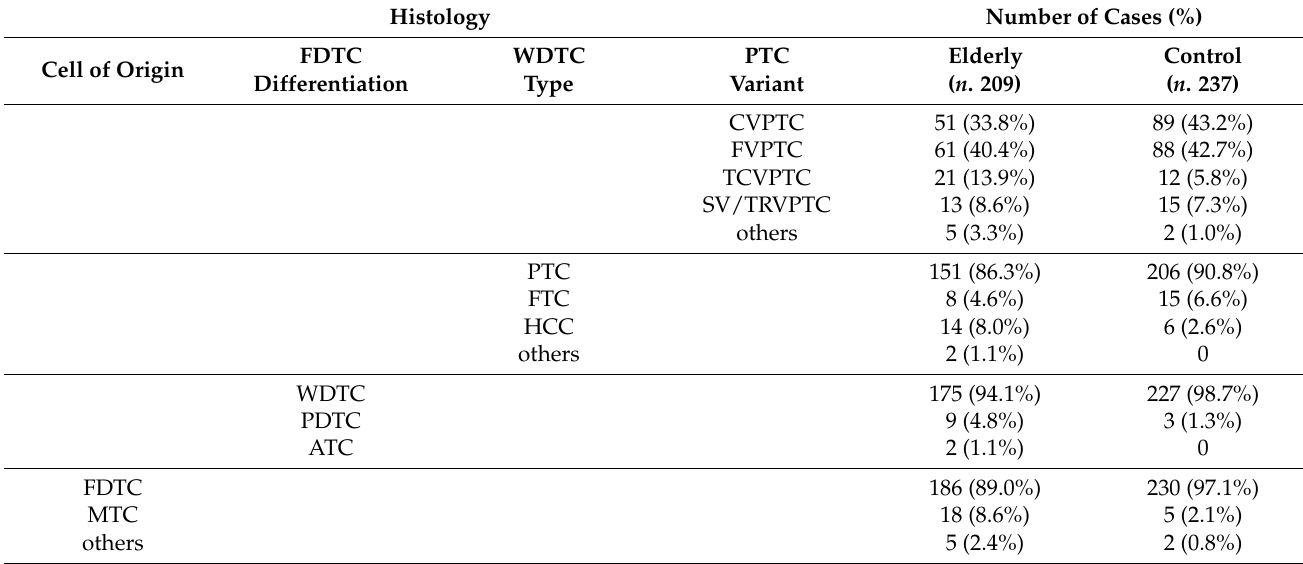
Table 2. Summary of histological diagnoses. Raw data and percentages for both elderly and the control group are reported. Histology Number of Cases